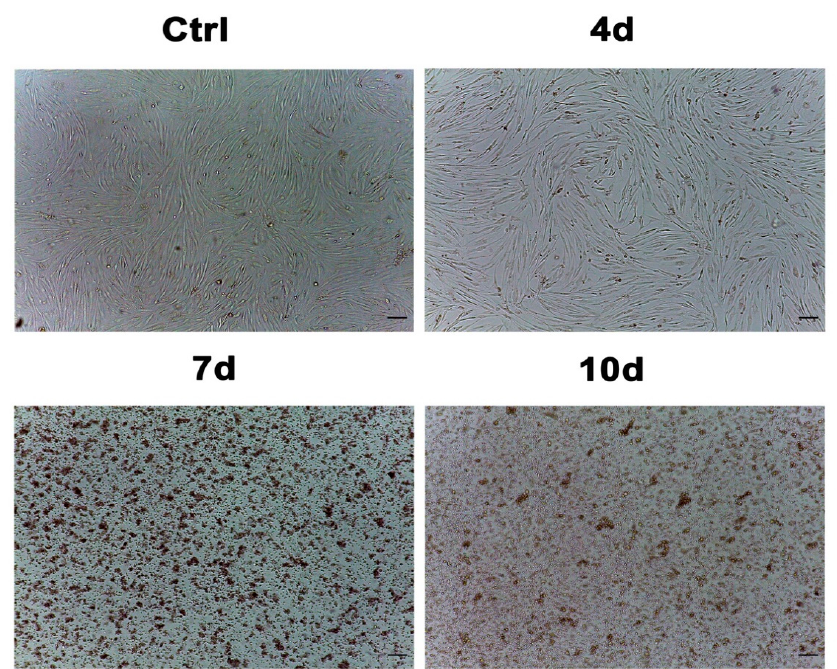
Figure 2. Optical microscope analysis of hADSC morphology after exposure to MCF-7-exhausted media. Figure 2 shows morphological changes in cell treated with 4d-MCF-7-EM (4d), or 7d-MCF-7-EM (7d) or 10d-MCF-7-EM (10d), as compared to untreated control cells (Ctrl). Scale bar = 100 µ m. 3.2. hADSCs Exposed to Exhausted Medium Undergo Cell-Cycle Progression through G1/S Phase The BrdU assay showed that cell proliferation was increased in hADSCs exposed to 4d-MCF-7-EM (4d - red bars), 7d-MCF-7-EM (7d - green bars), or 10d-MCF-7-EM (10d - blue bars), as compared to control untreated cells (Ctrl – grey bars). Cells treated with 10d-MCF-7-EM showed a higher proliferation rate when compared to cells cultured in all the other described conditions, but there is no significant difference compared to control cells (Figure 3).